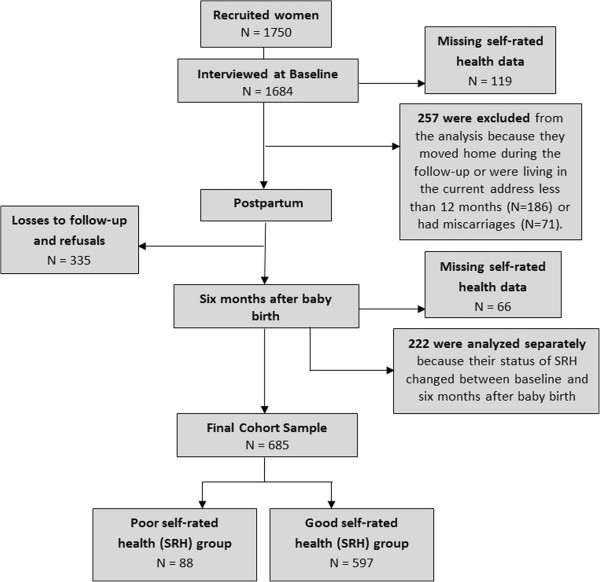
Flowchart of the sample.